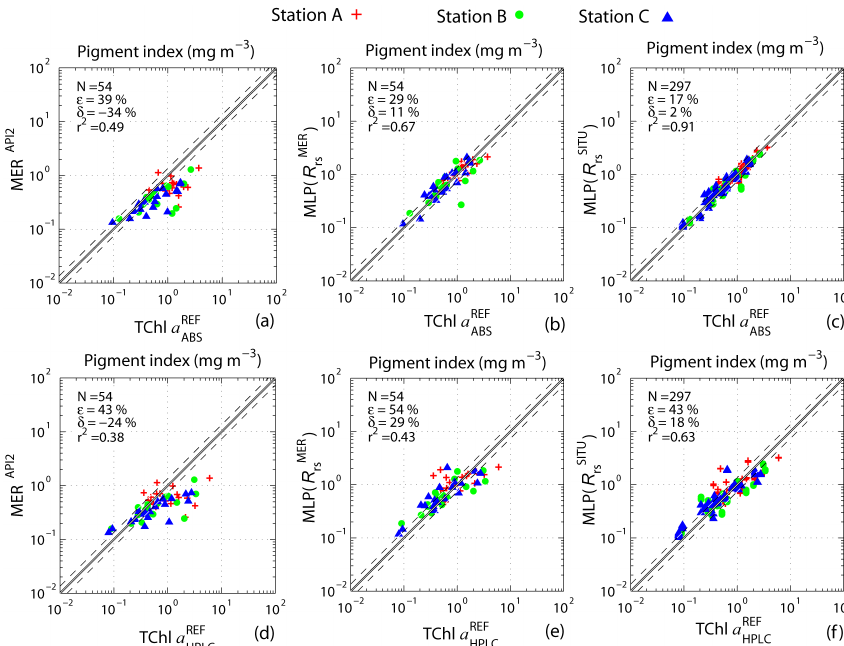
Figure 1. Comparison between MERIS standard Algal Pigment Index 2 and results obtained by applying the multilayer perceptron (MLP) regional scheme for the Sagres region. The top row panels present the matchup comparisons with respect to the in situ reference TChl a REF while the lower panels detail the matchup comparisons with TChl a REF